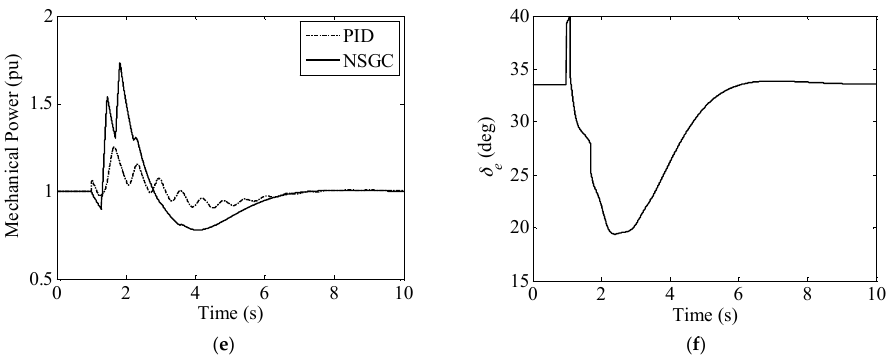
Figure 5. Responses to a three-phase short-circuit fault. ( a ) Rotor angle response; ( b ) Rotor angular speed response; ( c ) Electrical power response; ( d )Terminal voltage response; ( e ) Mechanical power response; ( f ) Reference change of the rotor angle. Energies 2017 , 10 , 1092